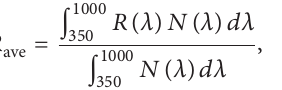
:H, and SiO 2 /SiN :H films is 3.42%, x x